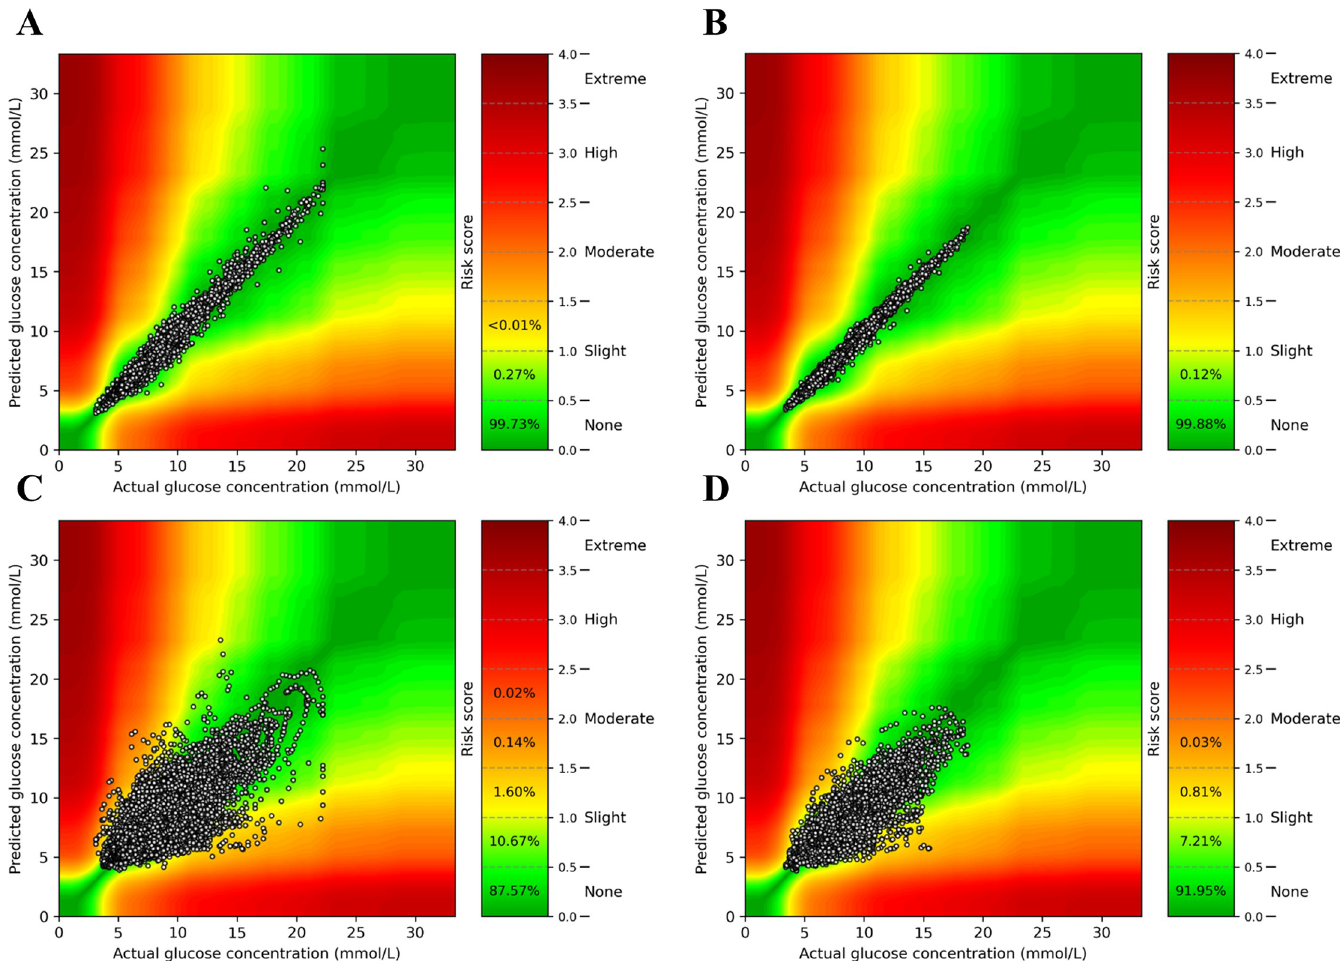
Fig 2. Surveillance error grid evaluation of glucose prediction safety at time intervals of 15 and 60 minutes in the main study population. Assessment of CGM- based glucose prediction safety in individuals with type 2 diabetes (n = 43) at 15 minutes (panel A) and 60 minutes (panel C). Assessment of CGM- and accelerometry- based glucose prediction safety in individuals with type 2 diabetes (n = 13) at 15 minutes (panel B) and 60 minutes (panel D). The risk score values translate to the following degrees of risk: 0–0.5, none; 0.5–1.0, slight (lower); 1.0–1.5, slight (higher); 1.5–2.0, moderate (lower); 2.0–2.5, moderate (higher); 2.5–3.0, great (lower); 3.0– 3.5, great (higher); > 3.5 extreme